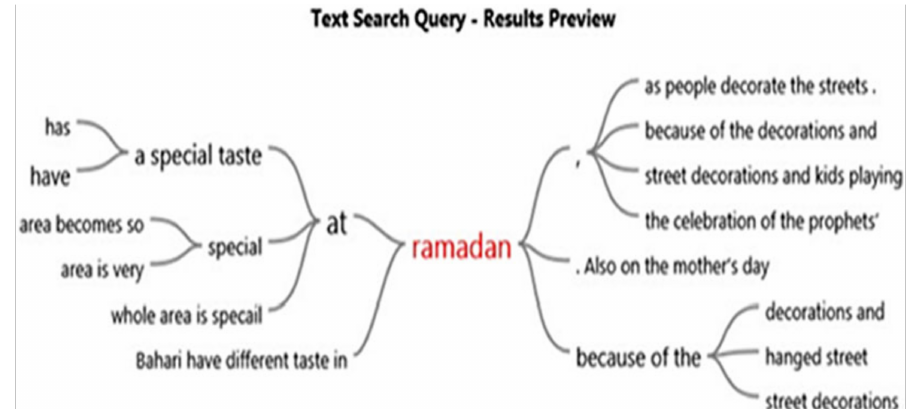
Figure 7. Word tree query, showing the frequency of mentioning Ramadan by the participants, extracted through Nvivo12. Source: F.